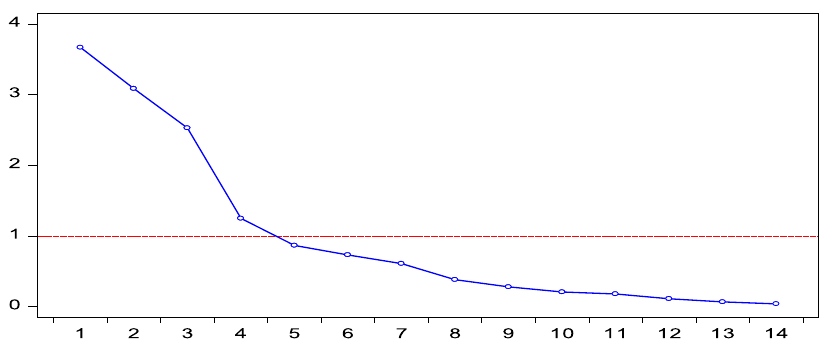
Fig. 1 Screen plot for PCA with ICRG indicators. This fi gure shows the Eigen values of estimated PCA of the main ICRG components. All PCA values were selected for calculating the political stability